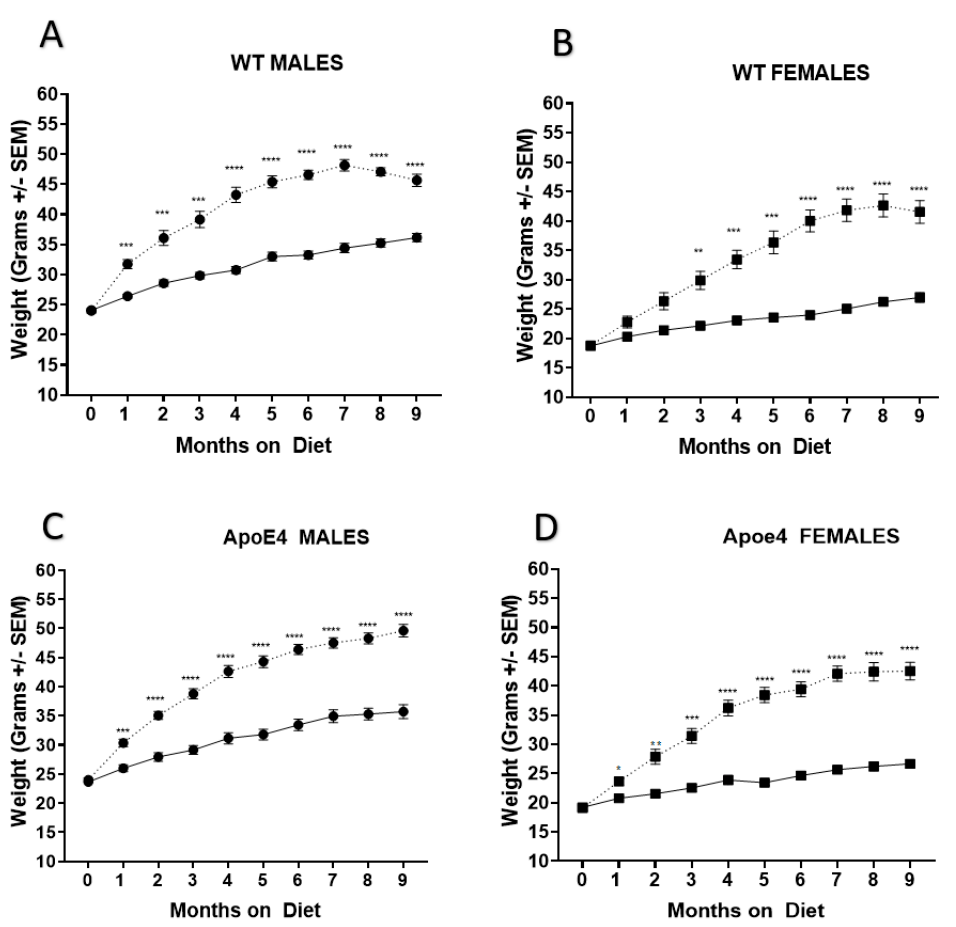
Figure 1. Body weights of WT and ApoE4 mice during the treatment period. Both male and female WT ( A , B ) and ApoE4 ( C , D ) mice gained weight at comparable rates throughout the study period. ... WD, - CONTROL; * p < 0.05, ** p < 0.01, *** p < 0.001, **** p <